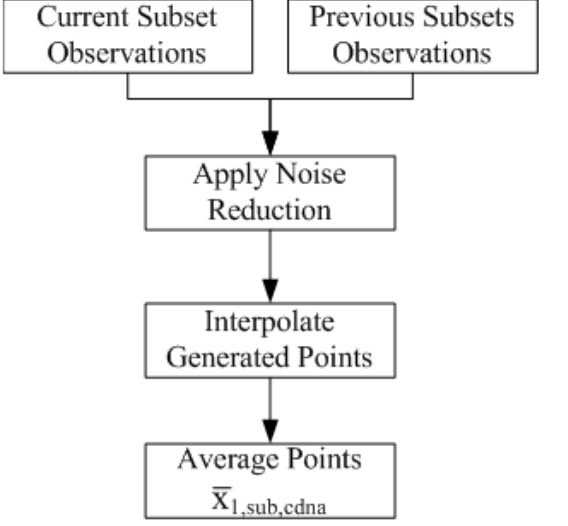
Fig. 3. Cumulative de-noised average. Table 1. Experiments design.